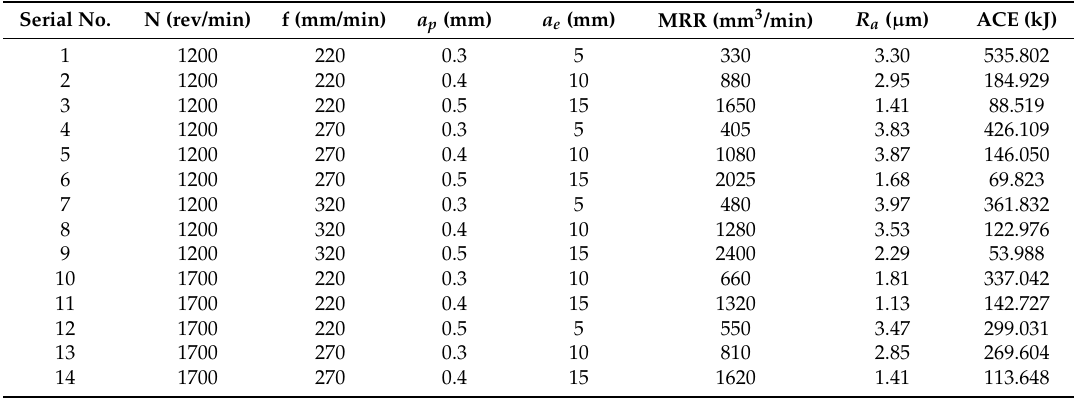
Table 2. Experimental design with measured values of responses. Serial No.